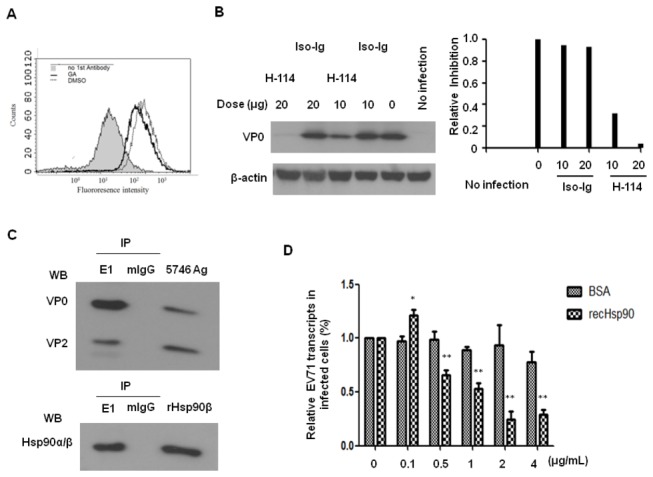
HSP90 interacts with EV71 on the surface of infected cells.(A) RD cells were treated with 2 µM (gray curve) or 0 µM (0.1% DMSO; black curve) of GA for one hour and then washed with 1xPBS before incubated with anti-HSP90 antibody (N-17) or control goat IgG (filled curve) at 4°C for another one hour. The cells were washed and fixed by 2% paraformaldehyde in PBS for 30 min. After washing, the cells were stained with anti-goat IgG-TR antibody and analyzed by the FACScan flow cytometer. (B) Pretreatment of RD cells with 10 and 20 µg of anti-HSP90 antibody (H-114) or control rabbit IgG (Iso-Ig) at 4°C for one hour before MOI=0.1 of EV71 5746 infection was conducted. After one hour infection, cells were washed with medium and incubated for another 16 hours. Viral capsid proteins in the cells were detected by western blot using MAB979 antibody. The internal β-actin was detected by blotting the same membrane with monoclonal anti-β-actin antibody. Corresponding changes in EV71 VP0 levels compared to the expression levels in the cells without antibody treatment as 1.0 were quantified using Image-Pro Plus 6.0 software. (C) Performance of co-immunoprecipitation of EV71 5746 and recombinant HSP90β by anti-EV71 E1 antibody or non-immune mouse IgG (mIgG) following by immunoprecipitation with protein G-agarose was described in the Materials and Methods. Precipitates were washed and subjected to detect the associated EV71 capsid proteins and HSP90 by blotting with MAb979 and anti-HSP90 antibodies, respectively. (D) MOI =0.1 of EV71 5746 was pre-mixed with various amounts of recombinant HSP90β or bovine serum albumin (BSA) and incubated at 4°C for overnight. EV71-HSP90β or EV71-BSA mixtures were inoculated into 12-well plate of RD cells and incubated on ice for 90 min. Followed by washing the unbound EV71 away, total RNA were extracted to quantify EV71 transcripts as described in the legend of Figure 4. Each normalized 2Ct value from EV71-HSP90β mixtures-treated cells was ratio to the value from the value of 2Ct obtained from the only EV71-treated cells that represented as 100%. A schematic representation of the percentage of EV71 attachment was shown. Unpaired student t test with Welch correction was used for statistical analysis.